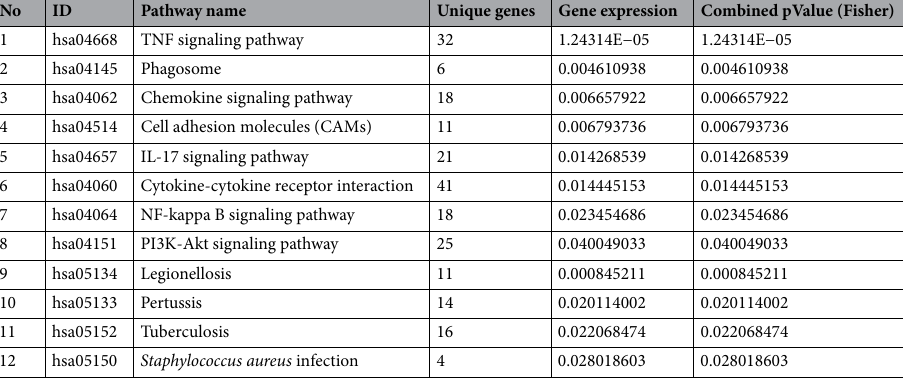
Table 4. Biological processes identified in the S. pneumoniae -induced and Lbp-induced transcriptomes of hBMECs by PaintOmics